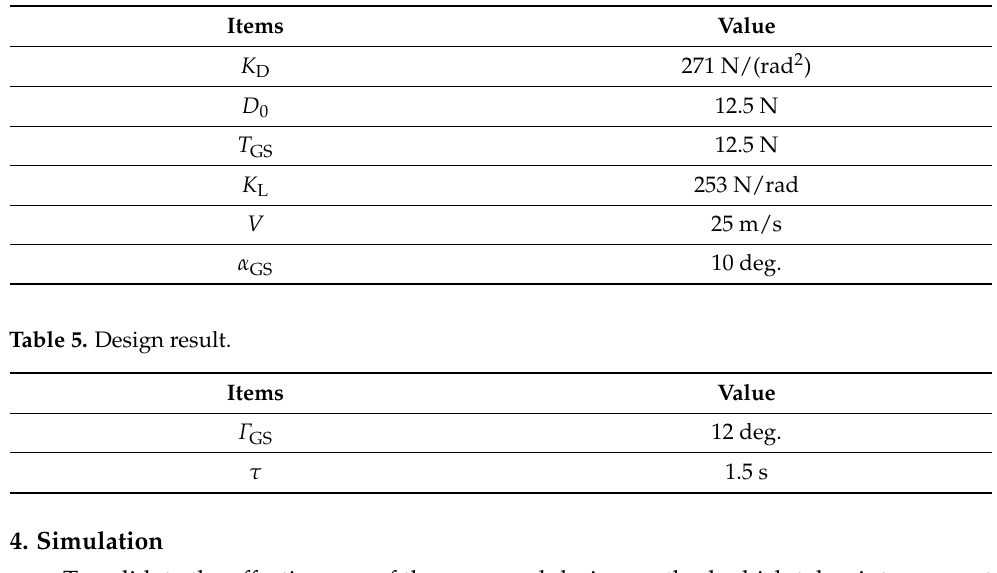
Table 4. Parameters used for design.